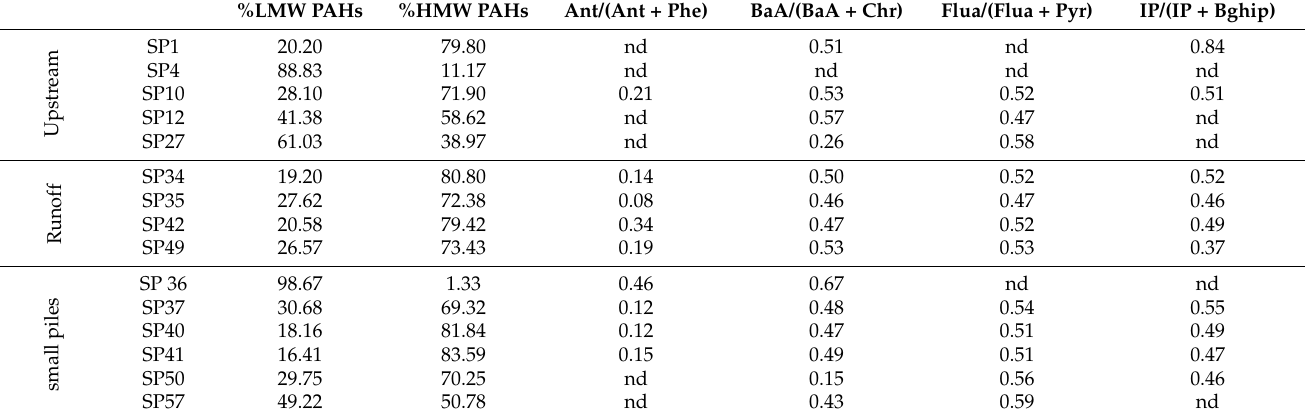
Table 8. LMW and HMW PAHs distribution in soils and isomer ratios for determining potential